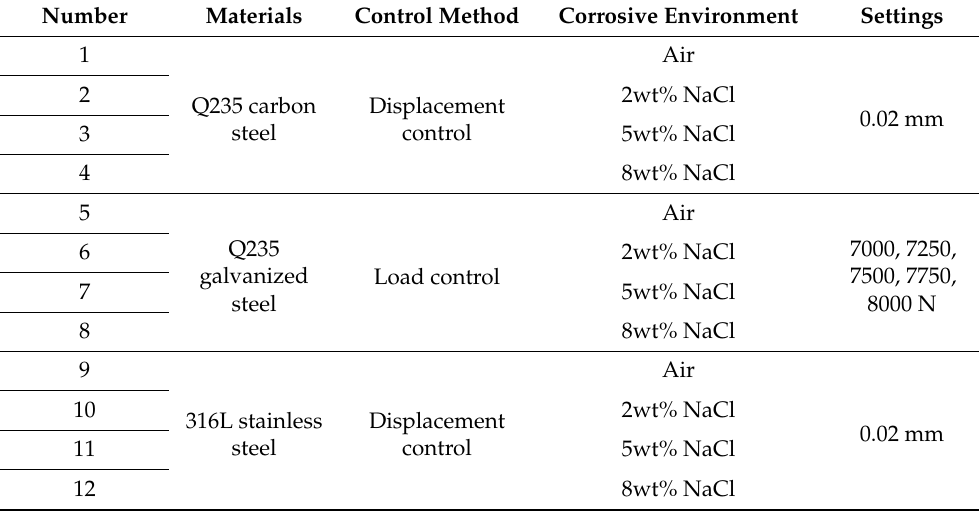
Table 4. Corrosion fatigue test parameter